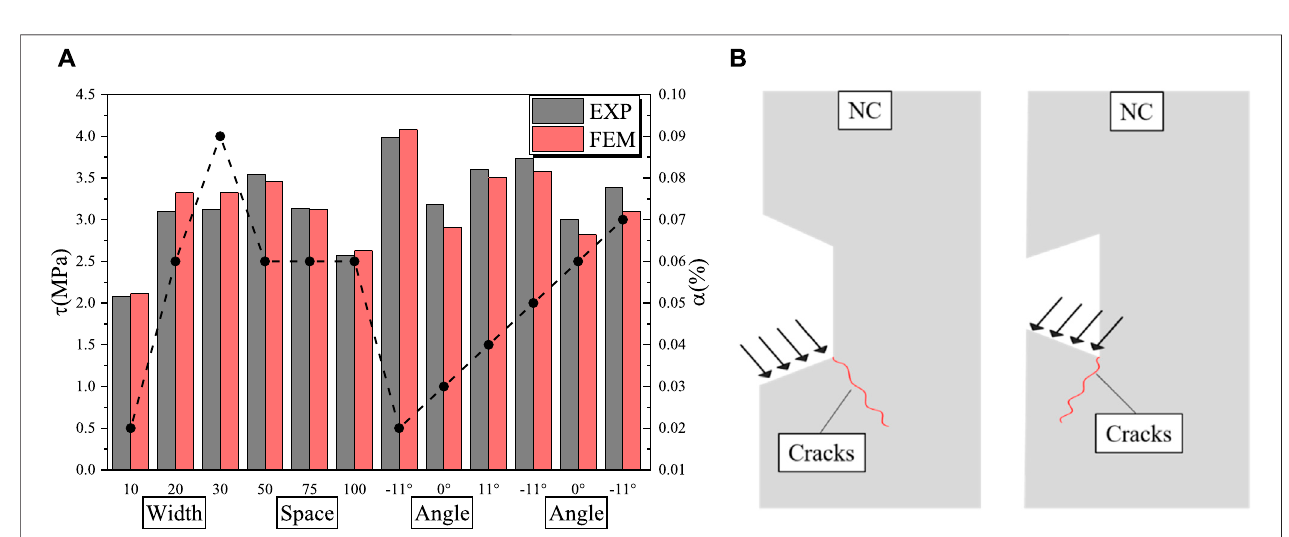
FIGURE 8 | In fl uence of different grooves. (A) Bonding strength. (B) Crack pattern of the grooves with different